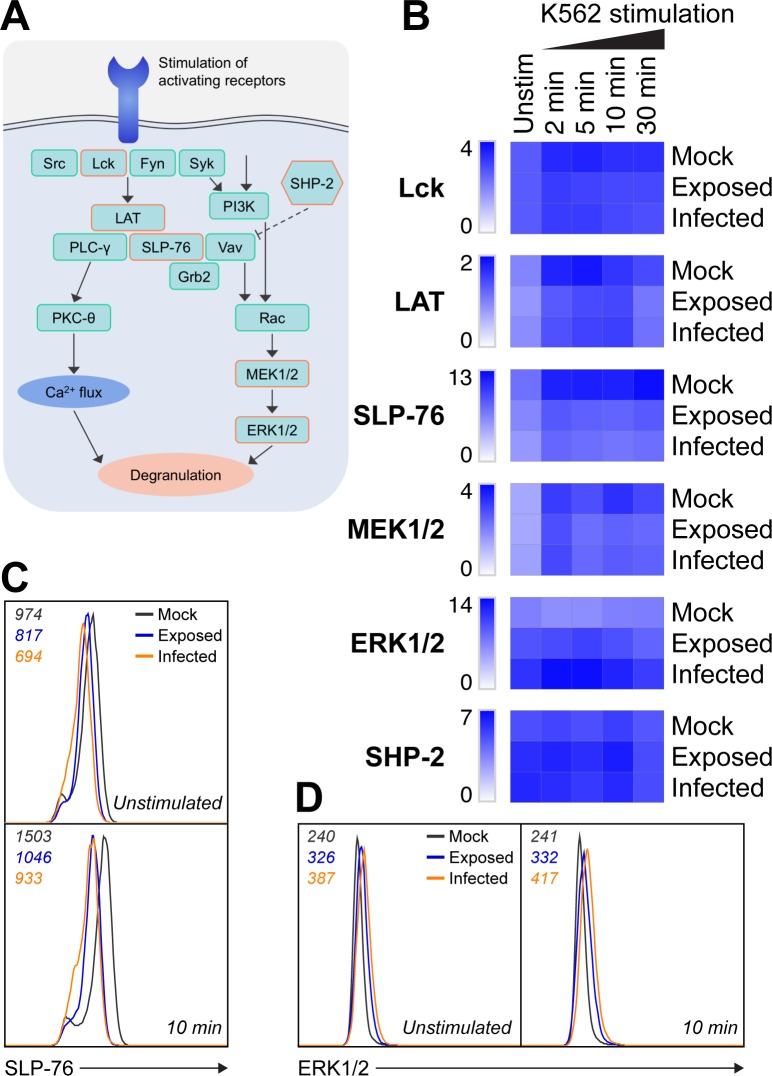
VZV culture interferes with NK cell signalling.(A) Simplified diagram of the general NK cell signalling pathway leading to degranulation, as well as the inhibitory action of SHP-2. Examined signalling molecules are indicated with an orange outline. (B-D) PBMCs were mock cultured, exposed to VZV, or VZV infected in the presence of 200 U/ml IL-2 for 1 day and either left unstimulated or stimulated with K562 cells for 2, 5, 10 or 30 min as specified. Phosphorylation of signalling markers in NK cells (CD3–CD56+ cells) was detected by flow cytometry. (B) Heatmap of phosphorylated signalling marker median fluorescence intensity (MFI) fold increase. (C) Histogram shows phospho–SLP-76 expression for NK cells unstimulated (above) and after 10 min stimulation with K562 cells (below). (D) Histogram shows phospho–ERK1/2 expression for NK cells unstimulated (left) and after 10 min stimulation with K562 cells (right). MFI values are indicated on the top left of the histogram. Data are representative of three donors. ERK1/2, extracellular signal-regulated kinase 1 and 2; Grb2, growth factor receptor-bound protein 2; LAT, linker for activation of T cells; MEK1/2, mitogen-activated or extracellular signal-regulated protein kinase kinase 1 and 2; PI3K, phosphatidylinositol 3-kinase; PKC-θ, protein kinase C-θ; PLC-γ, phospholipase C-γ; SHP-2, Src homology phosphatase 2; SLP-76, SH2 domain-containing leukocyte phosphoprotein of 76 kD.